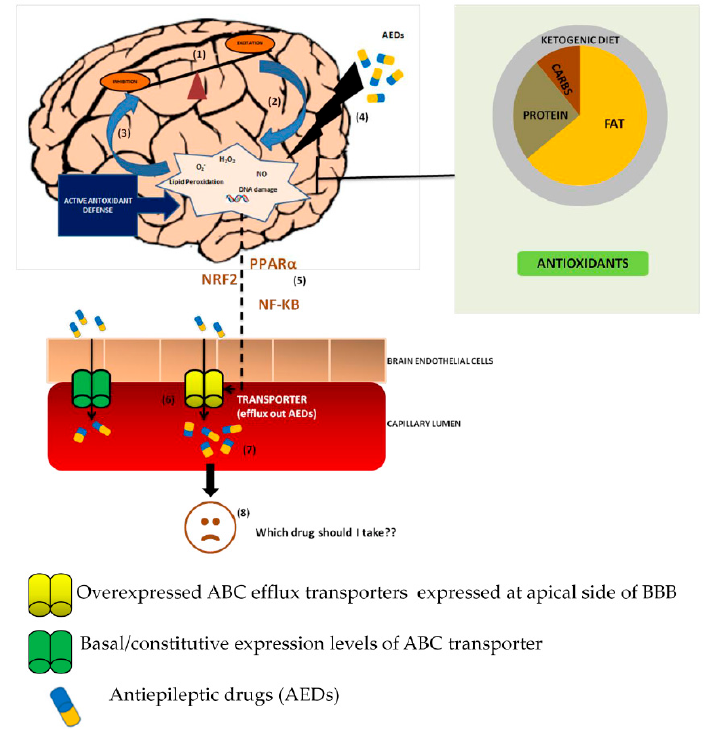
Figure 1. Modulation of ABC efflux transporter at blood brain barrier (BBB) by oxidative stress: possible mechanism of pharmacoresistance in epilepsy. Epilepsy results when the balance between neuronal excitability and inhibition is tipped towards excitability ( 1 ); This imbalance increases production of brain ROS molecules, leading to oxidative stress ( 2 ); The elevated stress in turn aggravates the epileptic condition forming a vicious cycle ( 3 ); First line AEDs given as a treatment to patients with epilepsy also raises oxidative stress levels, which become undesirable for the patients ( 4 ); This oxidative